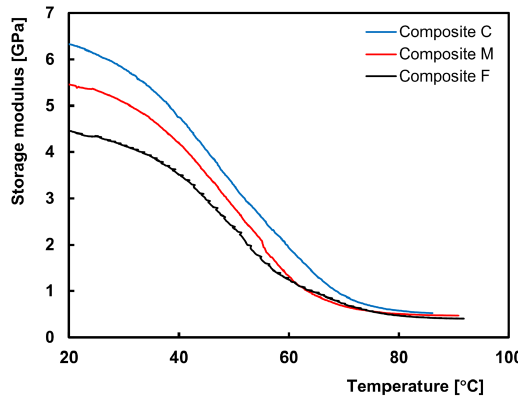
Figure 8. Average storage modulus (E’) versus